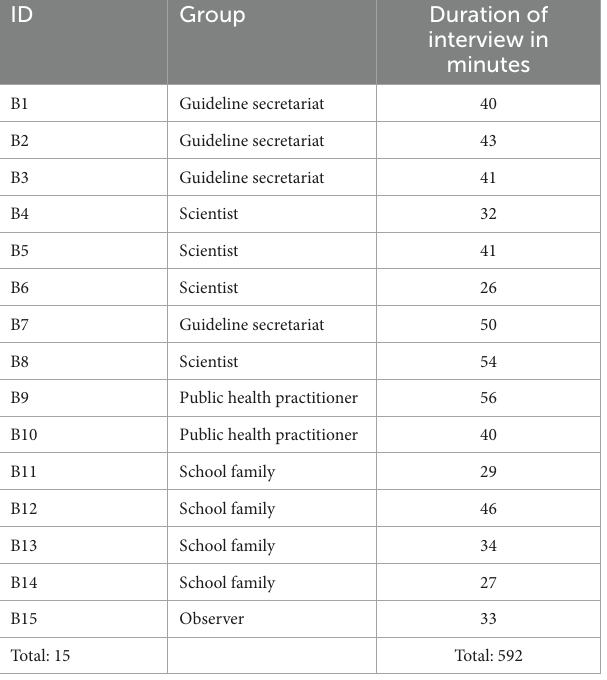
TABLE 3 Overview of study participants * and interview duration. ID Group Duration of